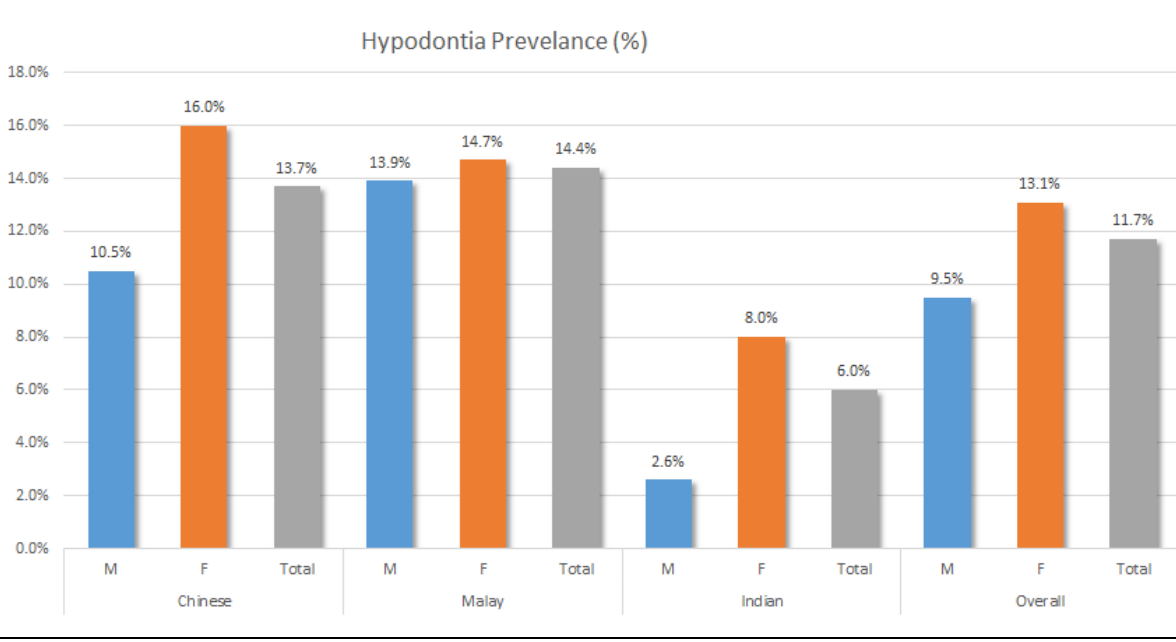
Figure 1. Hypodontia prevalence in the three ethnic